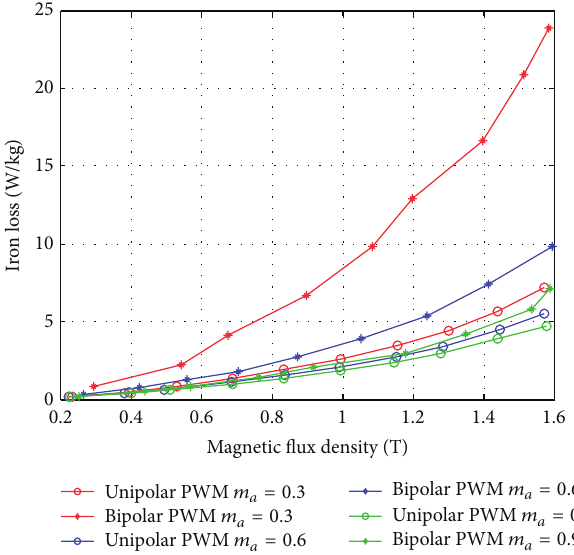
Figure 24: Iron loss versus flux density for bipolar and unipolar PWM(with 𝑓 =50Hzand 𝑚 𝑓 = 20 )atdifferent 𝑚 𝑎 valuesmeasured using the new toroidal frame.